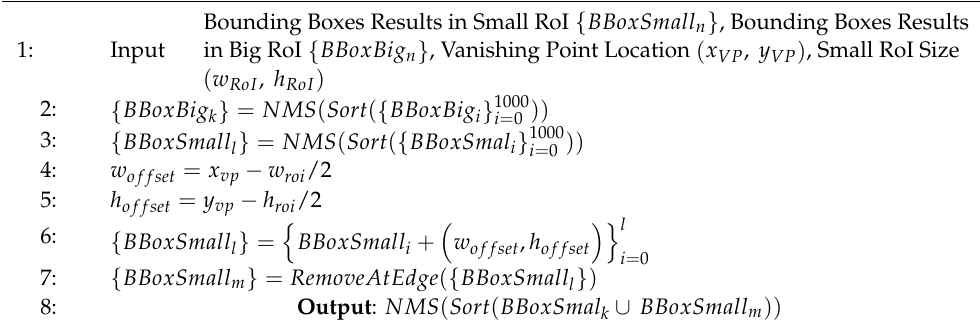
Algorithm 1 : ConcentrateNet multi-RoI Bounding Boxes Merging